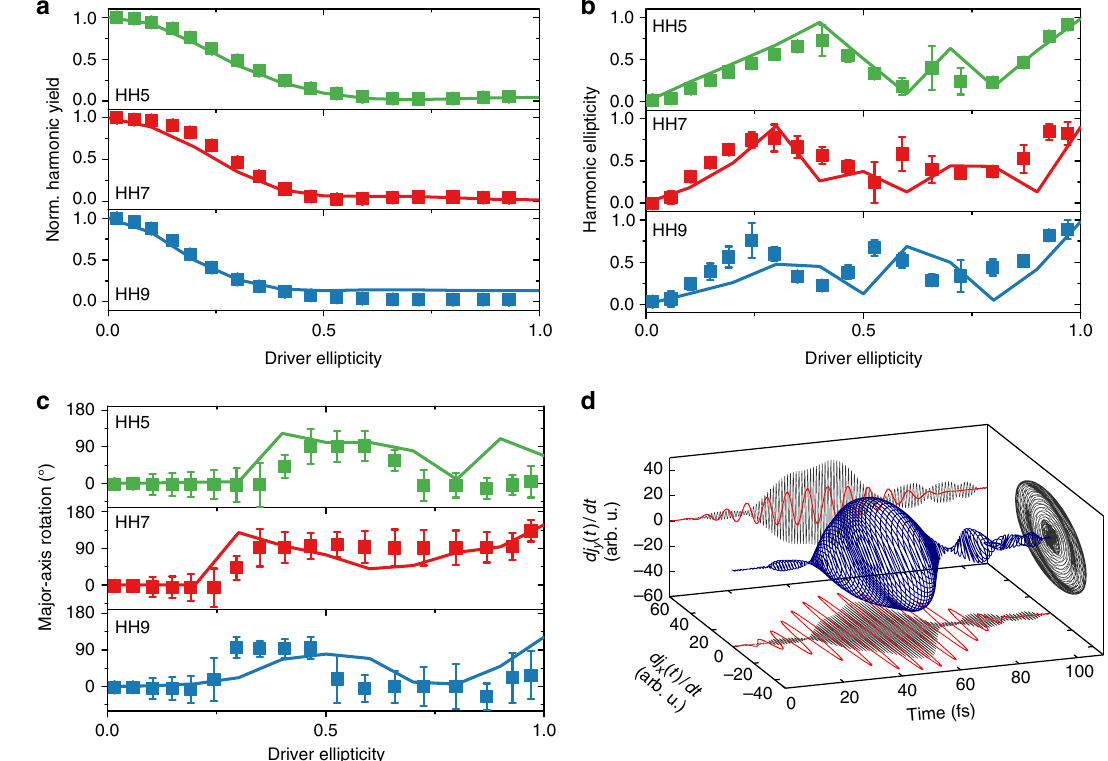
Fig. 4 Calculated polarization states of the harmonics compared to the experiment. Comparison between TDDFT simulations (solid lines) and experimental results for a the harmonic yield, b the harmonic ellipticity | ε HH |, and c the major-axis rotation of the harmonics ’ polarization ellipse of HH5 to HH9 versus the driver ellipticity. Here, θ = Γ X. For all plots, the values are interpolated between θ ¼ Γ X þ 2 (cid:2) (cid:3) and averaged over negative and positive ellipticity values. 3 (cid:2) The error bars are the averaged absolute deviations. d TDDFT result for the time-derivative of the electric current yielding HH7, for ε = 0.3 and θ = Γ X + 5°. The red curves show the x- and y -projections of the driving laser fi